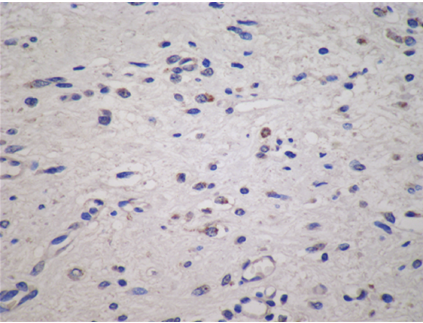
Figure 2: Immunohistochemical analysis using cleaved caspase- 3 antibody. Note the granular cytoplasmic positivity in apoptotic